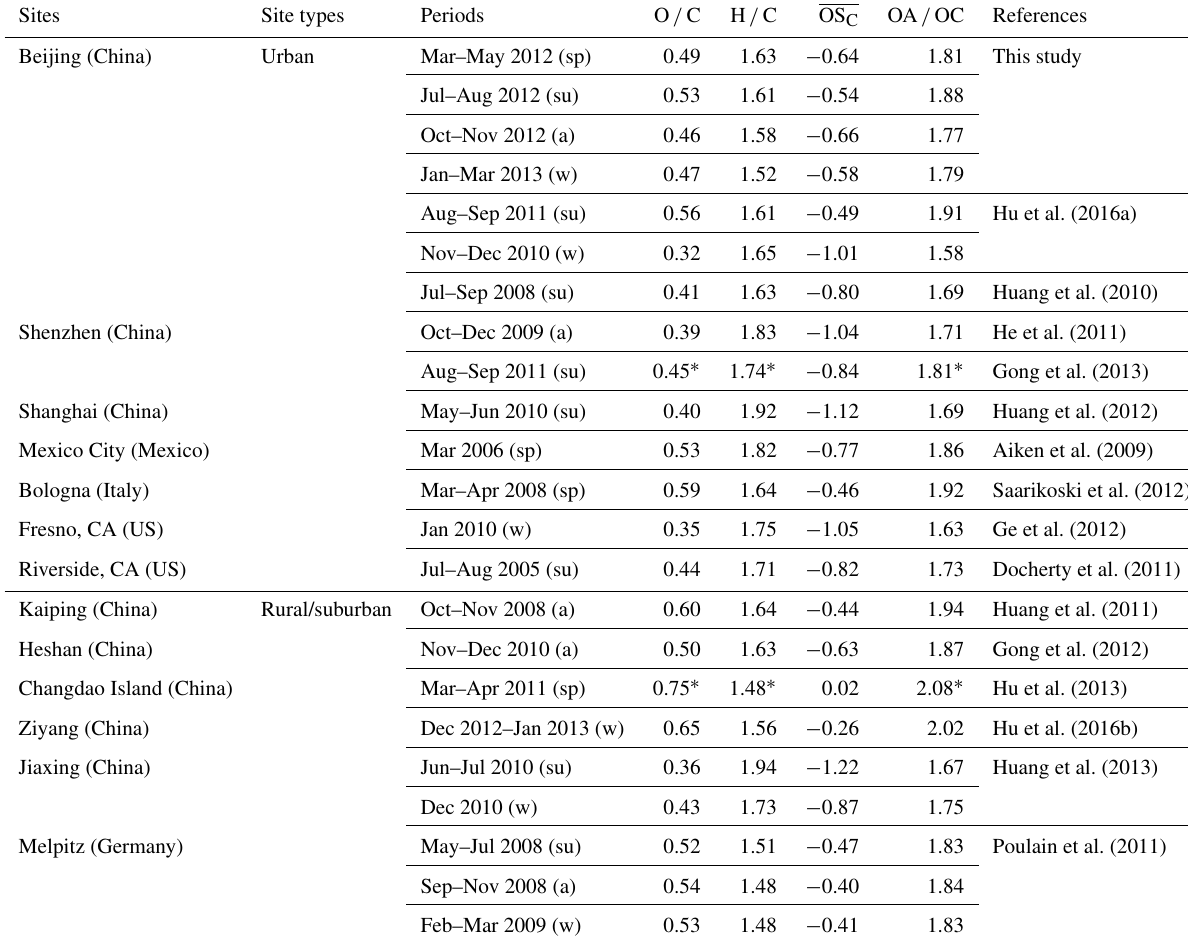
Table 2. Elemental ratios and OA / OC ratios in OA obtained from field observations at urban and rural/suburban sites. The ratios are corrected by the “improved-ambient” method (Canagaratna et al., 2015), except for Hu et al. (2013) and Gong et al. (2013). Abbreviations in parentheses correspond to seasons (sp: spring; su: summer; a: autumn; w: